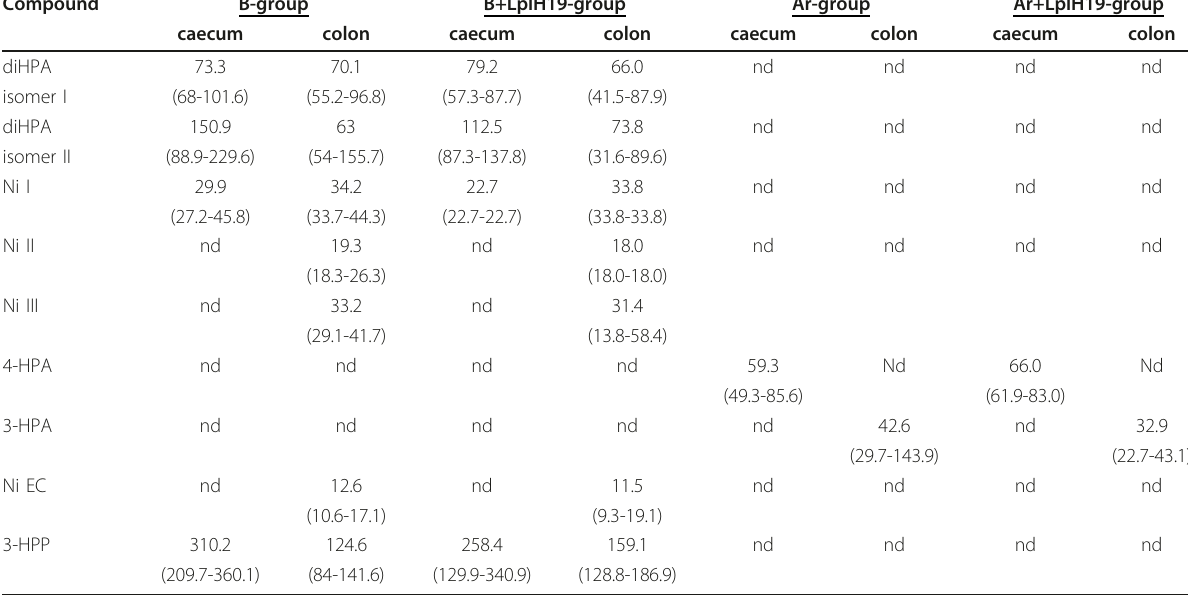
Table 3 Concentrations ( μ g/g) of aromatic acid metabolites in caecum and colon of mice administrated billberry (B) or chokeberry (Ar) alone or supplemented with strain L. plantarum HEAL19